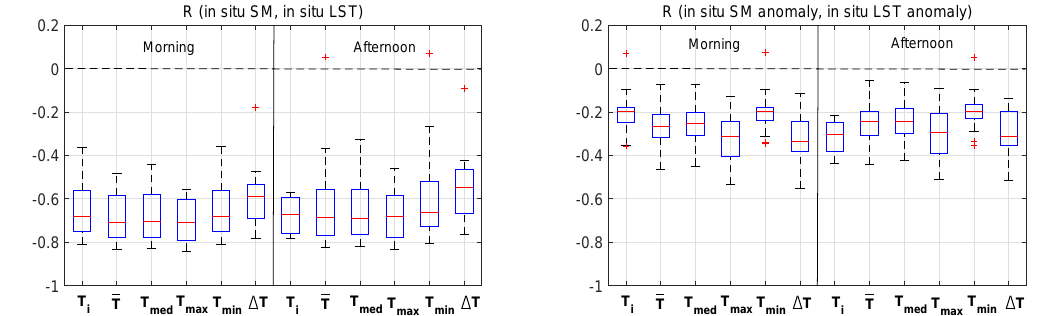
Figure 5. Correlation (R) of in situ SM acquired at the SMOS morning/afternoon passes and LST derived parameters ( left ) and their anomalies ( right ) for: (i) instantaneous T i ; (ii) daily mean T ; (iii) daily median T med ; (iv) daily maximum T max ; (v) daily minimum T min ; and (vi) diurnal range ∆ T = T max − T min . Outliers are depicted with red crosses.